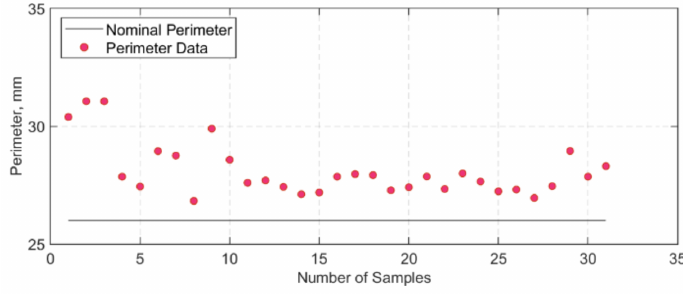
Figure 8. Perimeter values of each sample, after analysis in ImageJ.